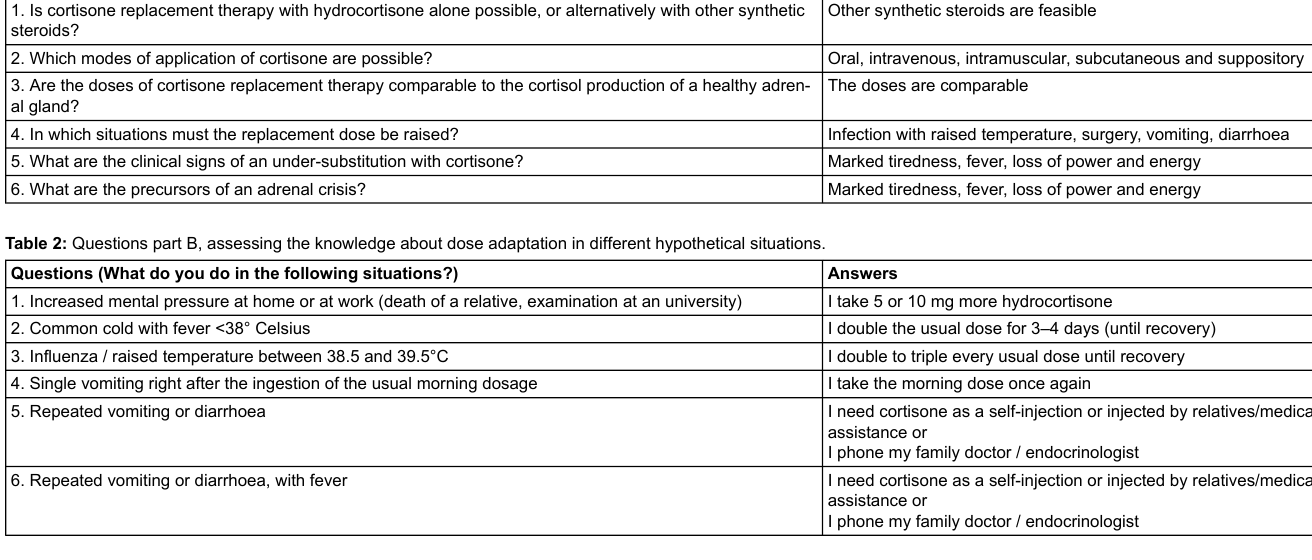
Table 1: Questions Part A, which assessed knowledge about the biomedical background of cortisone replacement. Questions